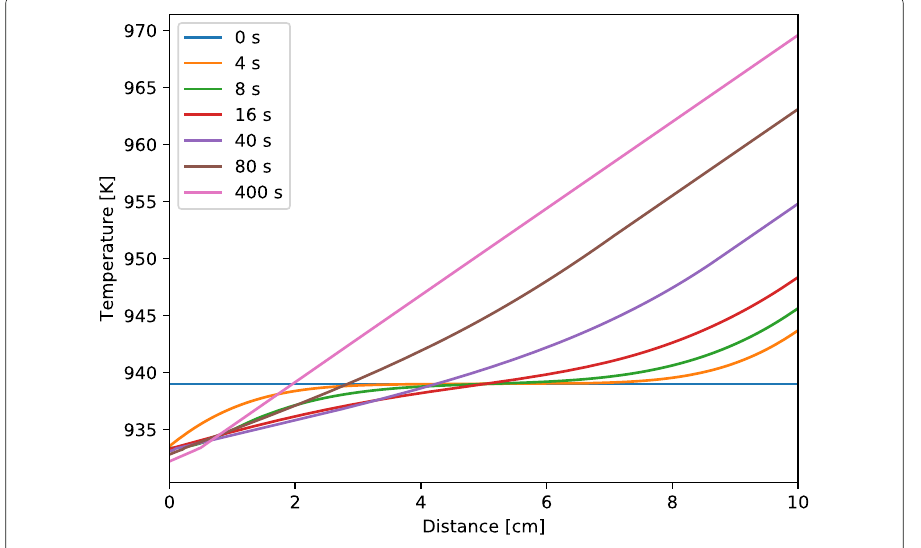
Fig. 17 Evolution of the temperature field for case (d) in Fig.